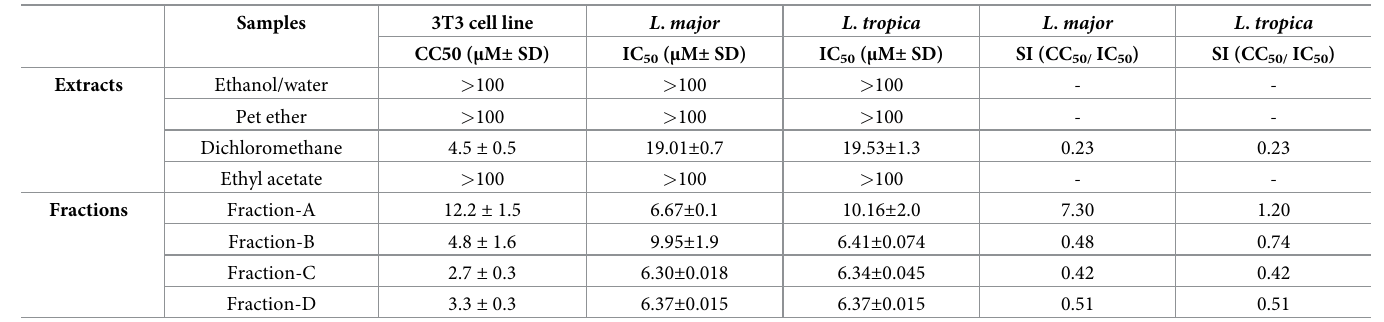
Table 7. Selectivity index of pure compounds against 3T3 mouse fibroblast cell line. Samples